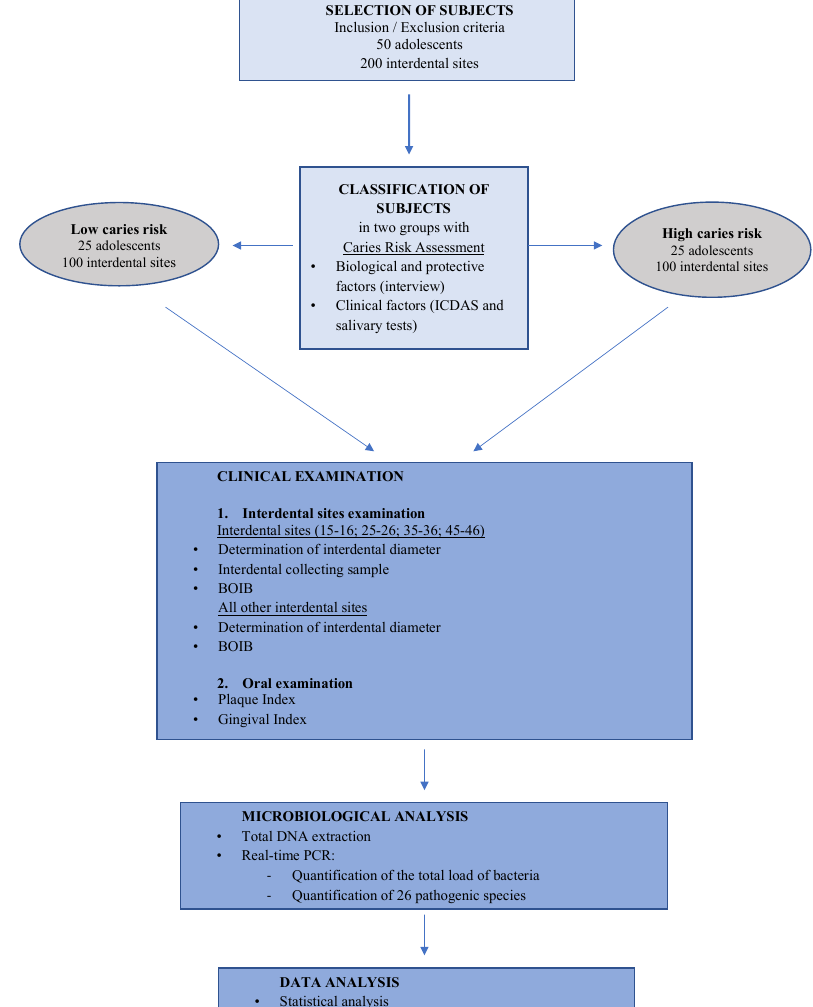
Figure 1. Workflow of the experiment. BOIB: Bleeding on Interdental Brushing; DNA: Deoxyribonucleic acid; ICDAS: International Caries Detection and Assessment System; PCR: Polymerase Chain